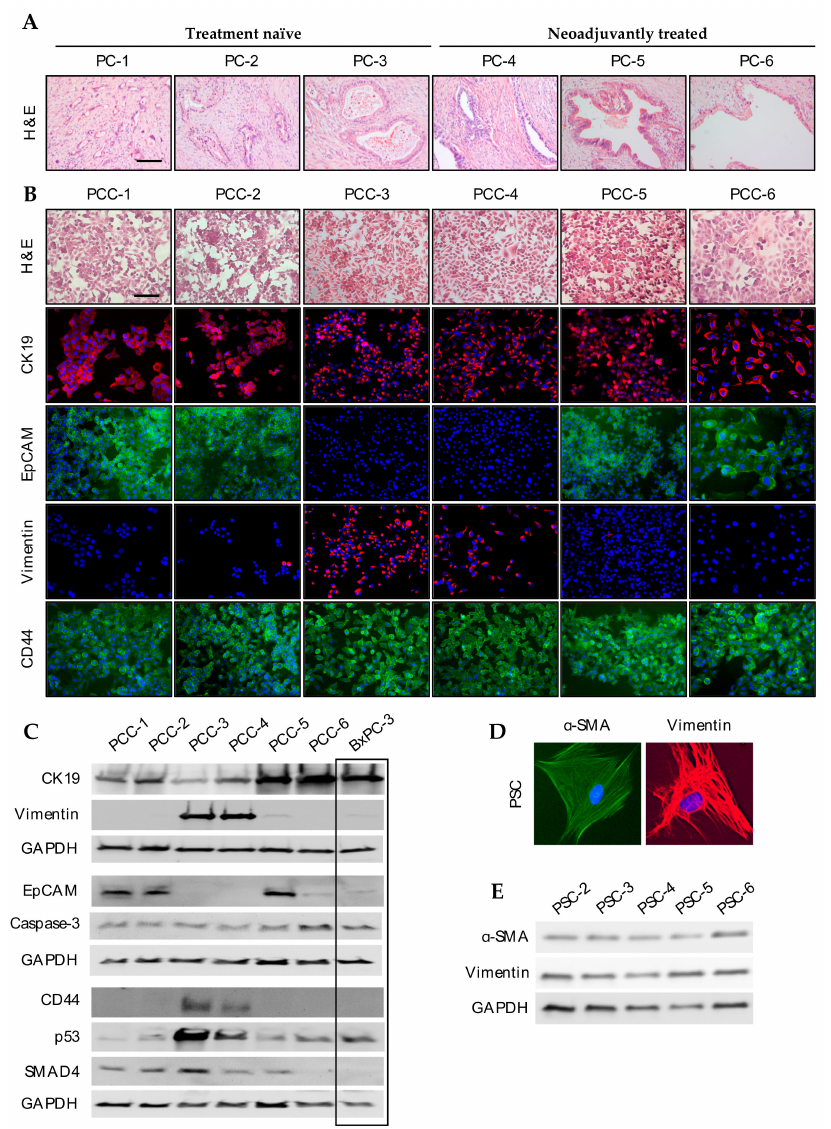
Figure 1. Morphology and expression analysis: ( A ) H&E staining of representative source tumors from which PCCs and PSCs were derived. Scala bar = 50 µ m. Paired primary cultures of PCCs and PSCs originated from the same individual PDAC tumor specimen assessed for morphology and expression analysis: ( B ) PCCs stained with hematoxylin and eosin (H&E); immunostained with antibodies against cytokeratin 19 (CK19), transmembrane glycoprotein epithelial cell adhesion molecule (EpCAM), vimentin, and CD44. Scale bar = 100 µ m. ( C ) PCCs were lysed and proteins were subjected to immunoblotting using antibodies against CK19, EpCAM, vimentin, CD44, p53, SMAD4, and Caspase-3. ( D ) PSCs immunostained with anti- α -smooth muscle actin ( α -SMA; green) and anti-vimentin (red) antibodies. ( E ) PSCs were lysed and proteins were subjected to immunoblotting using antibodies against α -SMA and vimentin. For Figure 1B,D, nuclei were stained with DAPI (blue). GAPDH was used as a loading control for Figure 1C,E. PC, pancreatic cancer; PCC, pancreatic cancer cell; PSC, pancreatic stellate